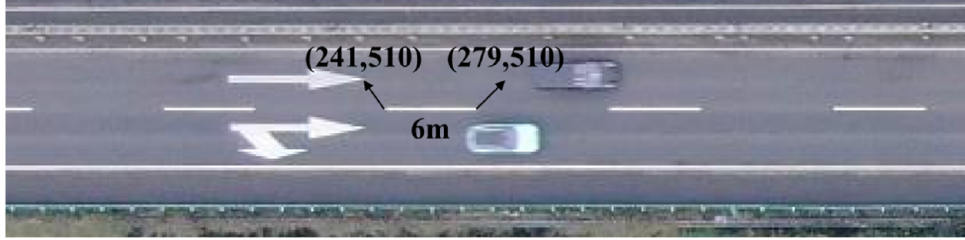
Figure 7. Distance parameter calibration.